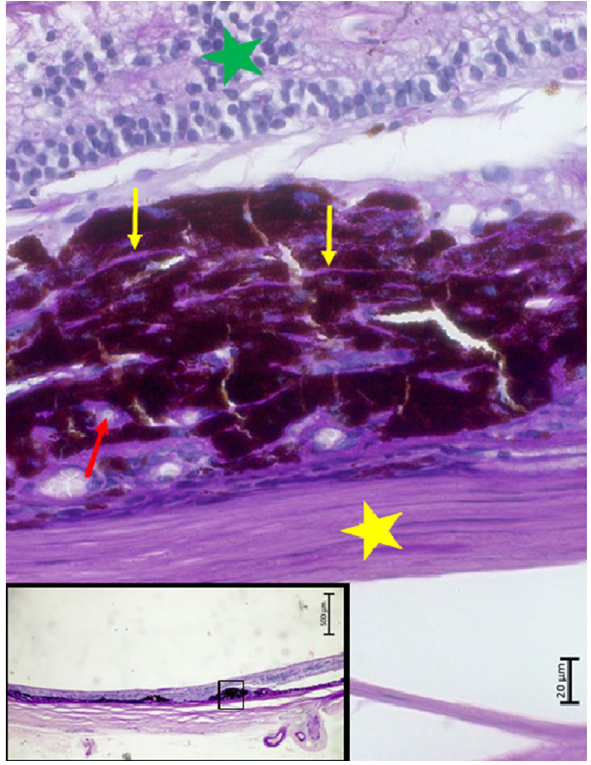
Figure 3. Histophotograph showing a neovascular myopic macular degeneration with irregular proliferations of irregularly pigmented retinal pigment epithelium cells, connected with a PAS (Periodic-Acid-Shiff)-positive, crumbled basal membrane (yellow arrows), retinal capillaries (red arrow), and fibrous tissue, located beneath a disarranged retina (green asterisks); yellow asterisks: